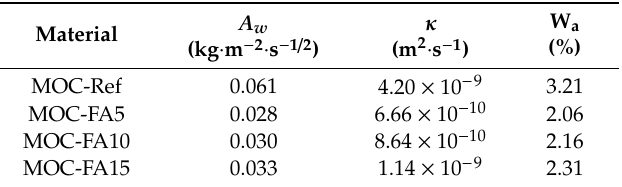
Table 7. Water transport and storage parameters of developed